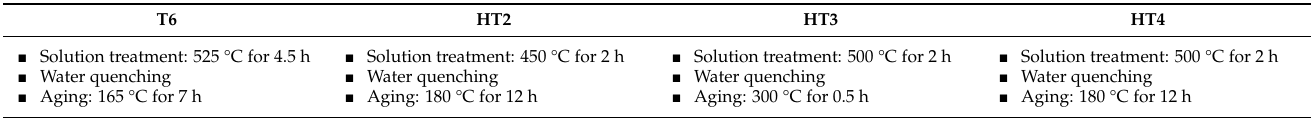
Table 2. Investigated ASI10Mg heat treatments Data from